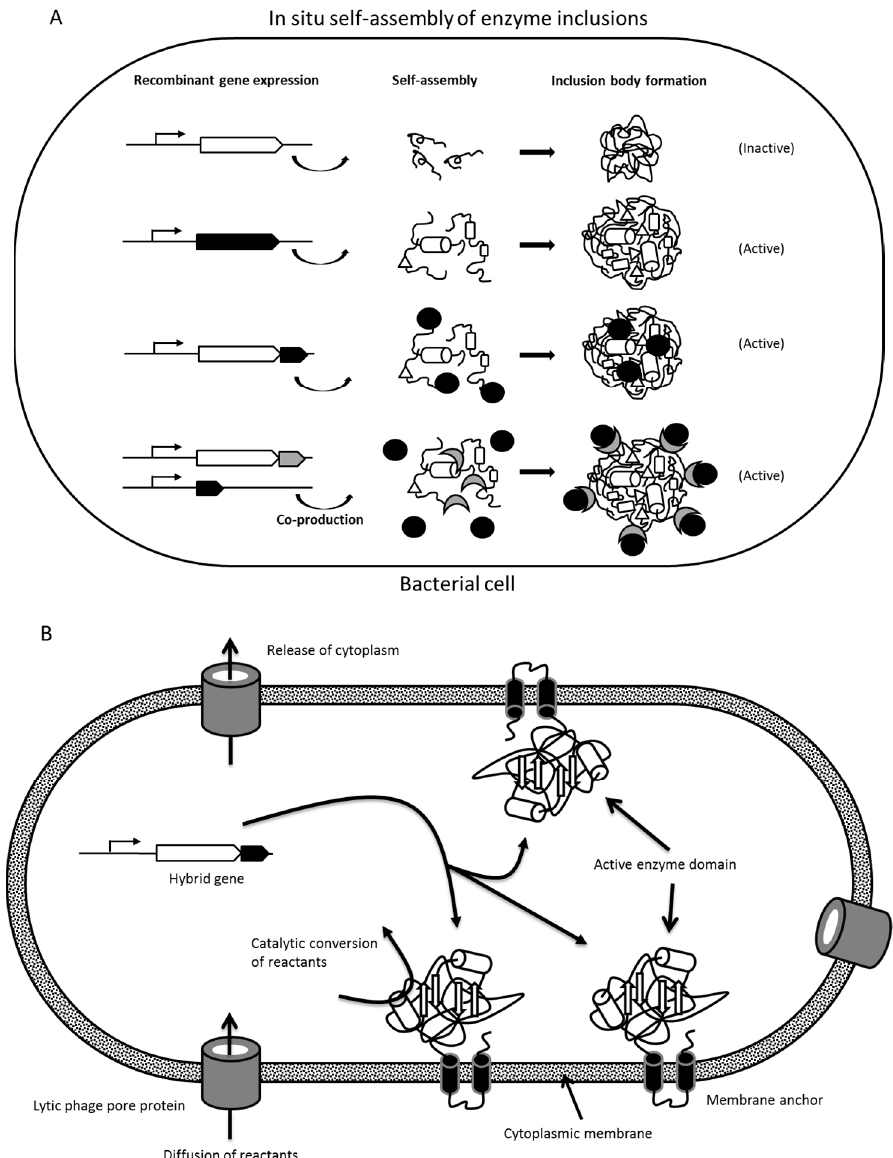
Figure 2. In situ enzyme immobilization: ( A ) Different modes of protein assembly leading enzyme inclusions. Black shapes indicate the target enzyme; ( B ) Immobilization of target enzyme by genetic fusion of a membrane anchor domain. Production of a phage pore enables release of intracellular content while retaining a membrane vesicle with immobilized enzyme.